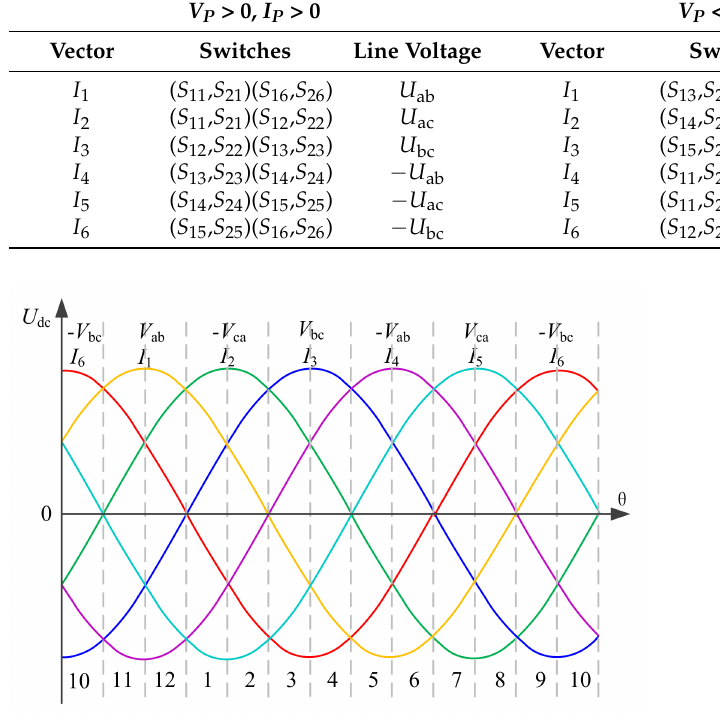
Figure 7. Line voltage and sector